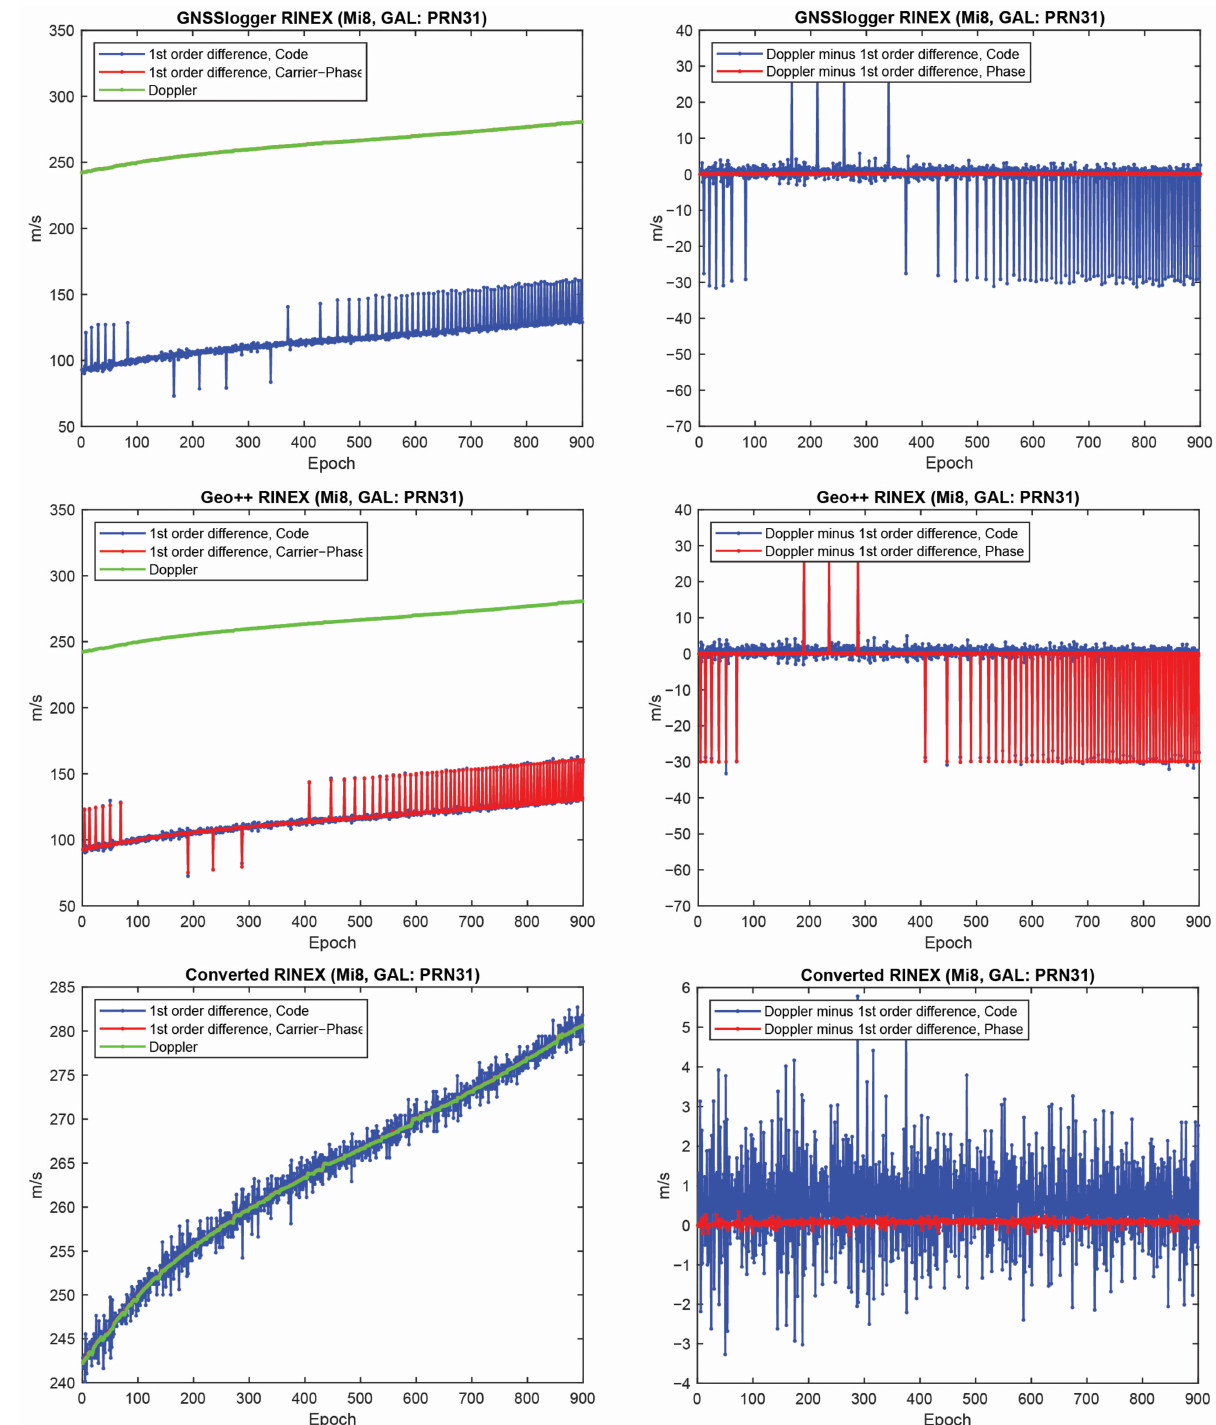
Figure 4. First-order differentiation of Galileo pseudorange and carrier-phase observations as well as Doppler observations on L1 frequency for PRN 31 (Xiaomi